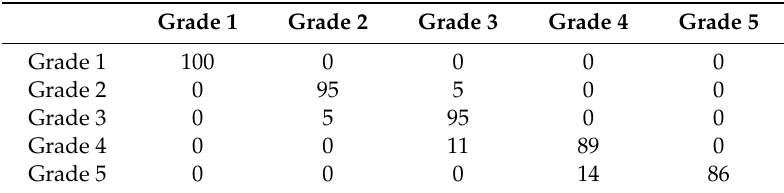
Table 13. System performance for area feature.